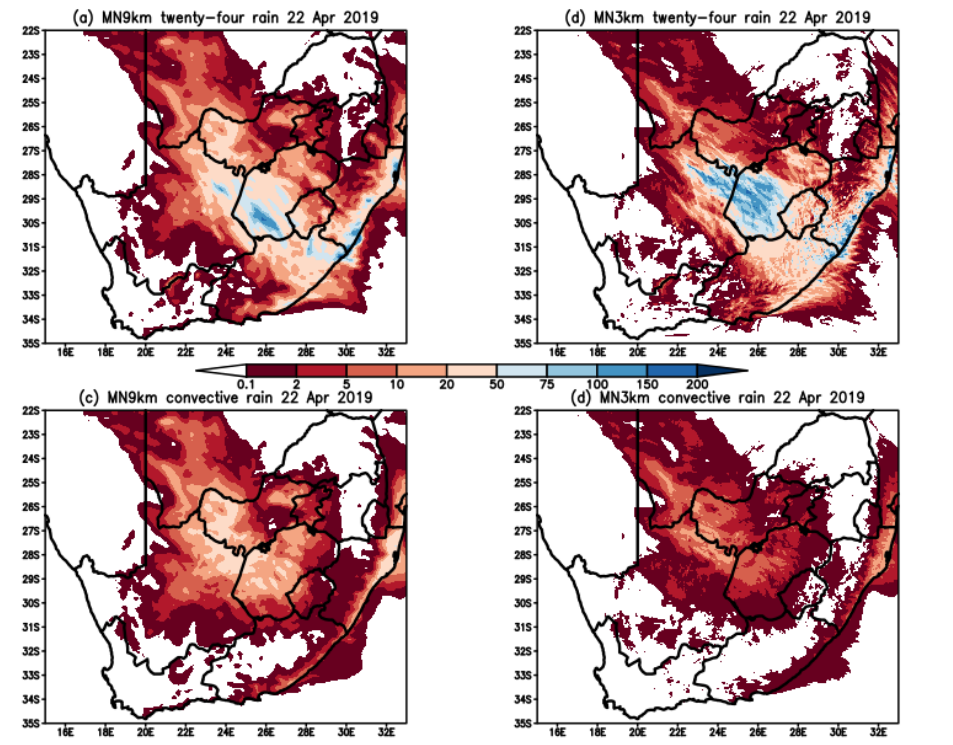
Figure 13. CCAM simulated twenty-four rainfall (mm) on 22 April 2019 for ( a ) MN9km and ( b ) MN3km, and convective rainfall from the cumulus scheme for ( c ) MN9km and ( d ) MN3km.